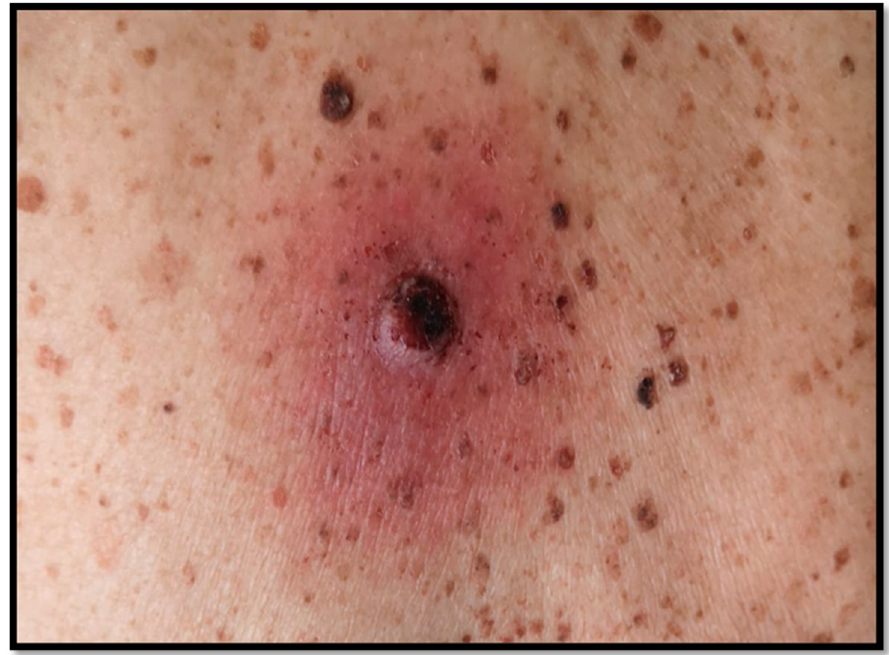
Figure 1. Clinical appearance of the nodular, bleeding lesion with irregular borders.